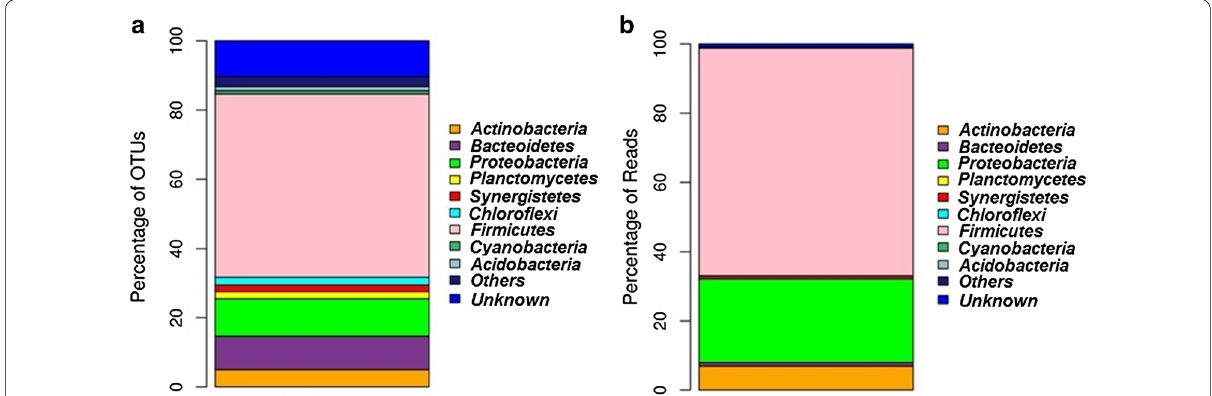
Fig. 4 Taxonomy classification of OTU’s at phylum level ( a ) and reads at phylum level ( b ) from sa - u m. Only top 10 enriched phyla categories are shown in the